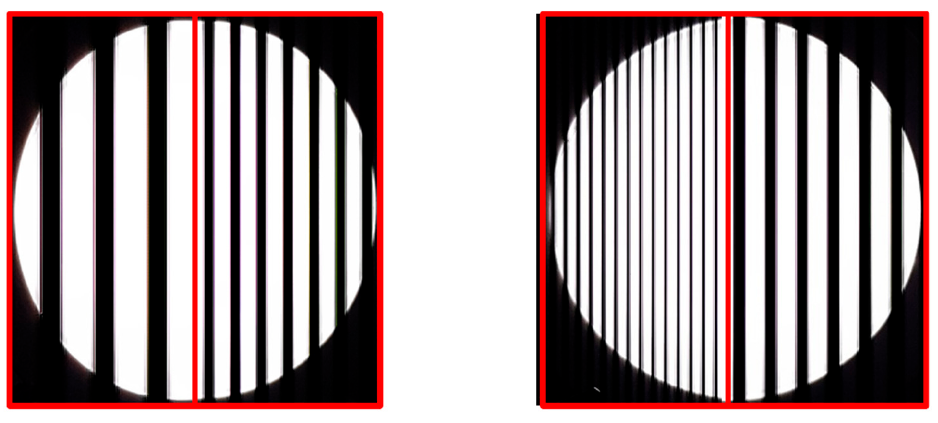
Figure 3. Rolling shutter captured image with mixed symbol data.